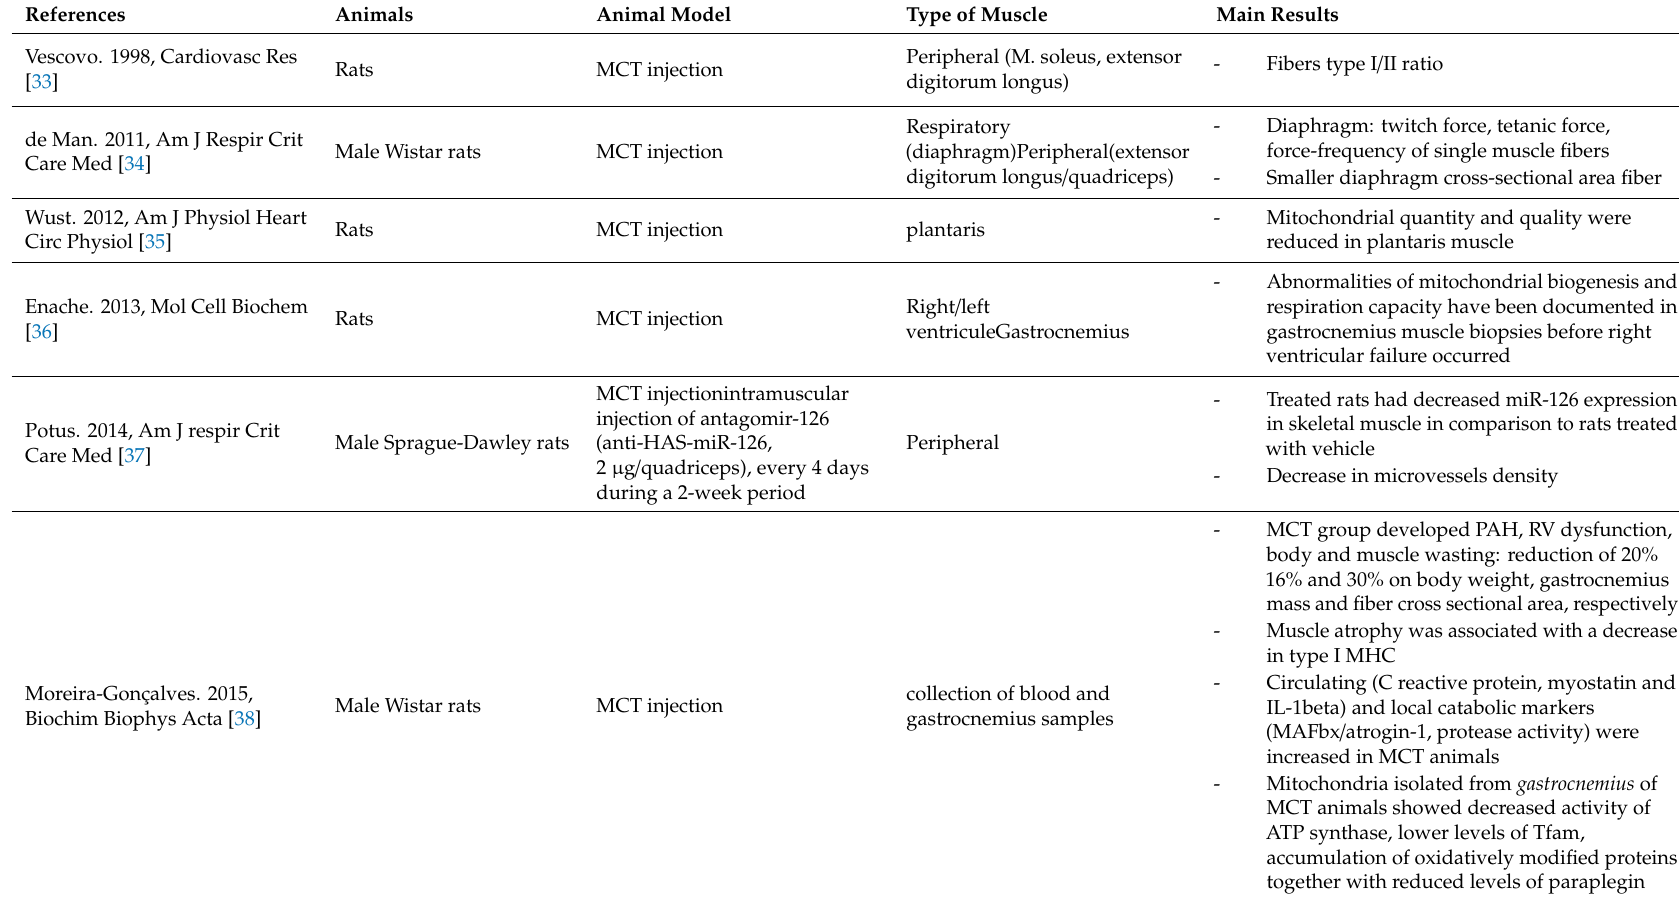
Table 1. Experimental data supporting pulmonary artery hypertension-related skeletal and respiratory muscles